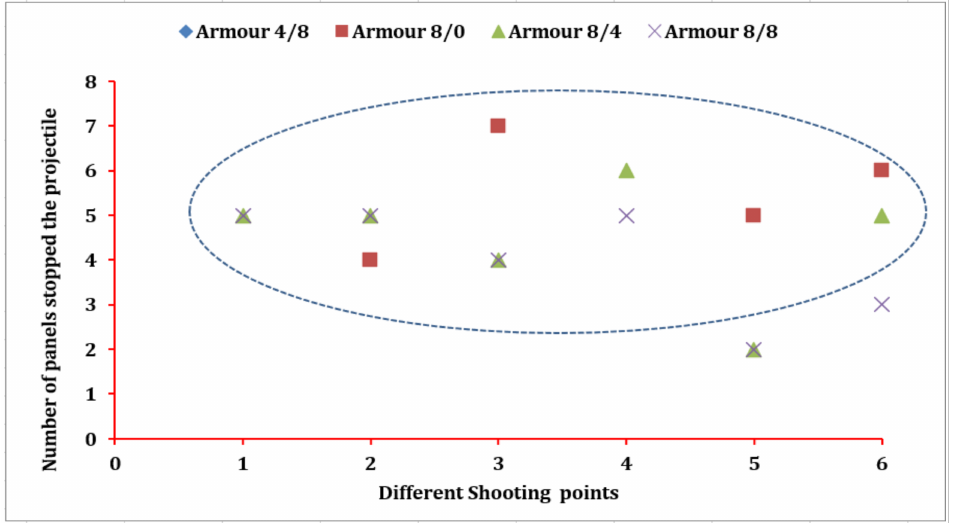
Figure 6. Armour panel number responsible to stop the projectile (All shots penetrated armour system 4/8, and shots one and four penetrated armour system